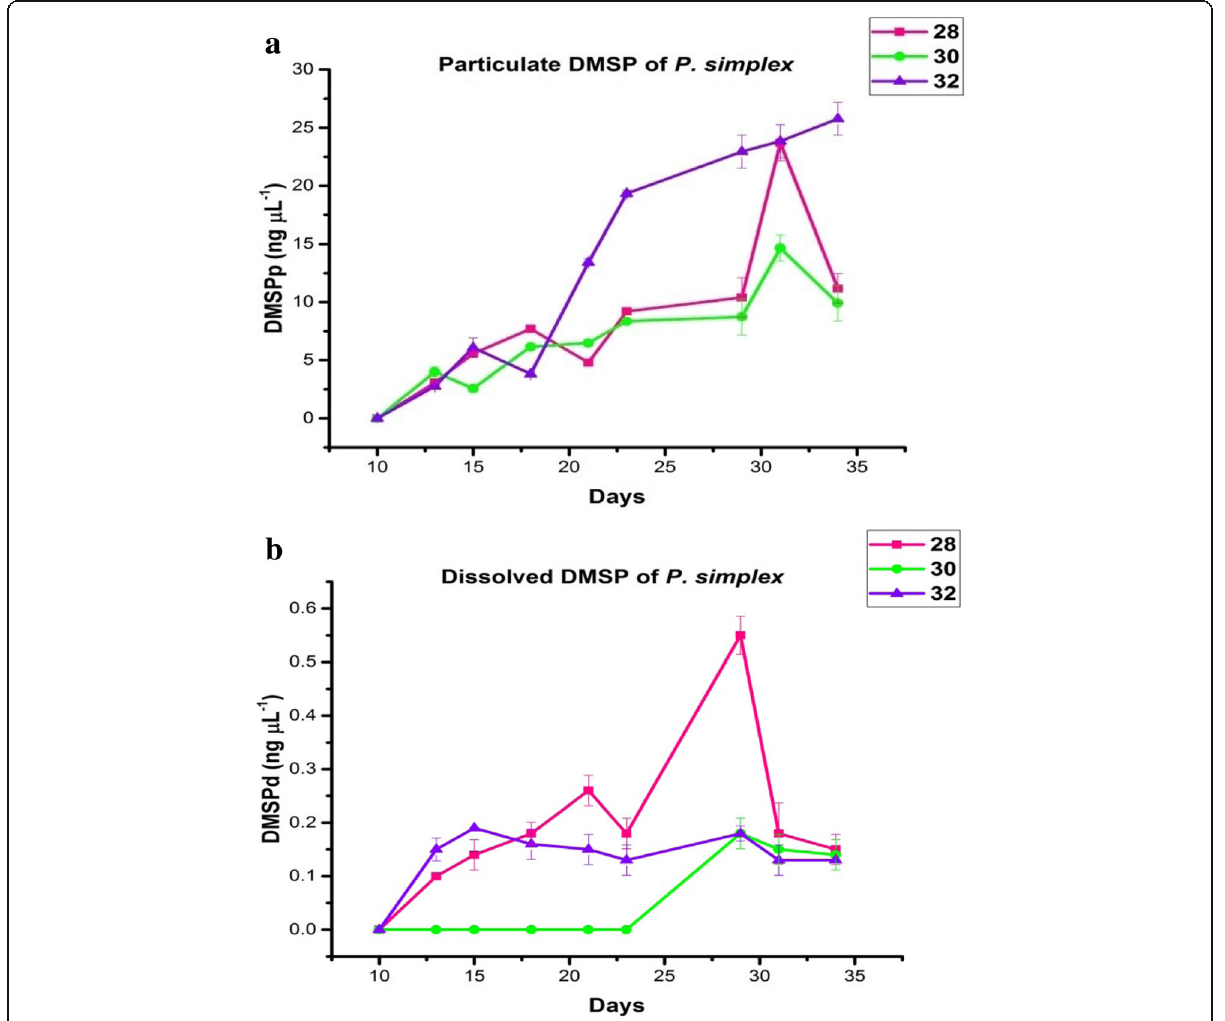
Fig. 4 ( a ) Effect of salinity (PSU) on DMSPp concentration in batch cultures of P. simplex and ( b ) effect of salinity (PSU) on DMSPd concentration in batch cultures of P.